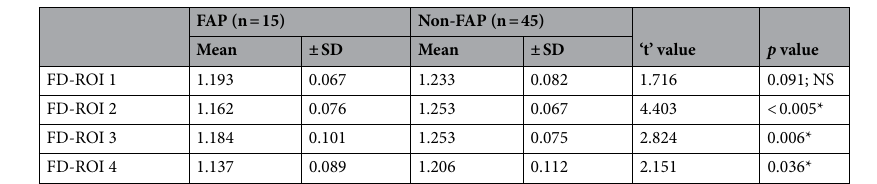
Table 1. Mean fractal dimension on each trabecular area in the FAP and non-FAP groups. NS: p > 0.05; * p < 0.05: Significant; ‘t’ = Student t test. FD fractal dimension, NS not significant, ROI region of interest, ROI 1 right mandibular angle, ROI 2 in the trabecular bone, 2 mm anterior to right mental foramen, ROI 3 in the trabecular bone, 2 mm anterior to left mental foramen, ROI 4 left mandibular angle, SD standard deviation.